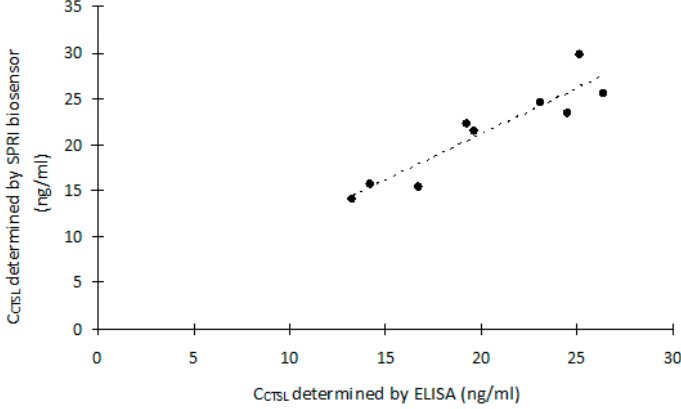
Figure 5. The linear correlation between the results of Cathepsin-L (CTSL) concentration in the blood plasma of the patients, obtained by Surface Plasmon Resonance Imaging (SPRI) method and ELISA.